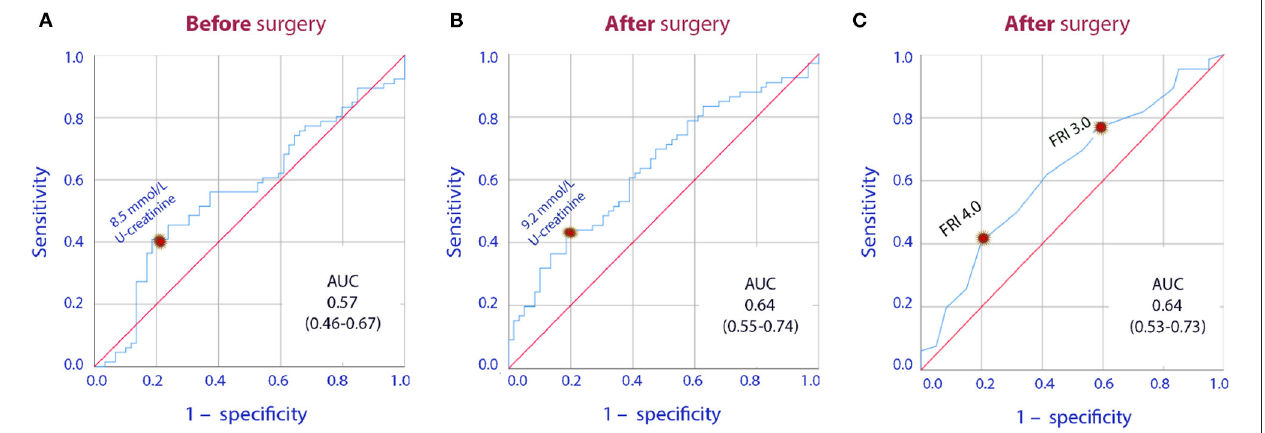
FIGURE 1 | Receiver Operating Curves (ROC) for the U-creatinine concentration measured (A) prior to surgery, (B) one day after surgery, (C) the Fluid Retention Index (FRI) measured one day after surgery when used to indicate whether or not there was a perioperative increase in plasma creatinine. AUC are under the curve followed by the 95% confidence interval is shown.